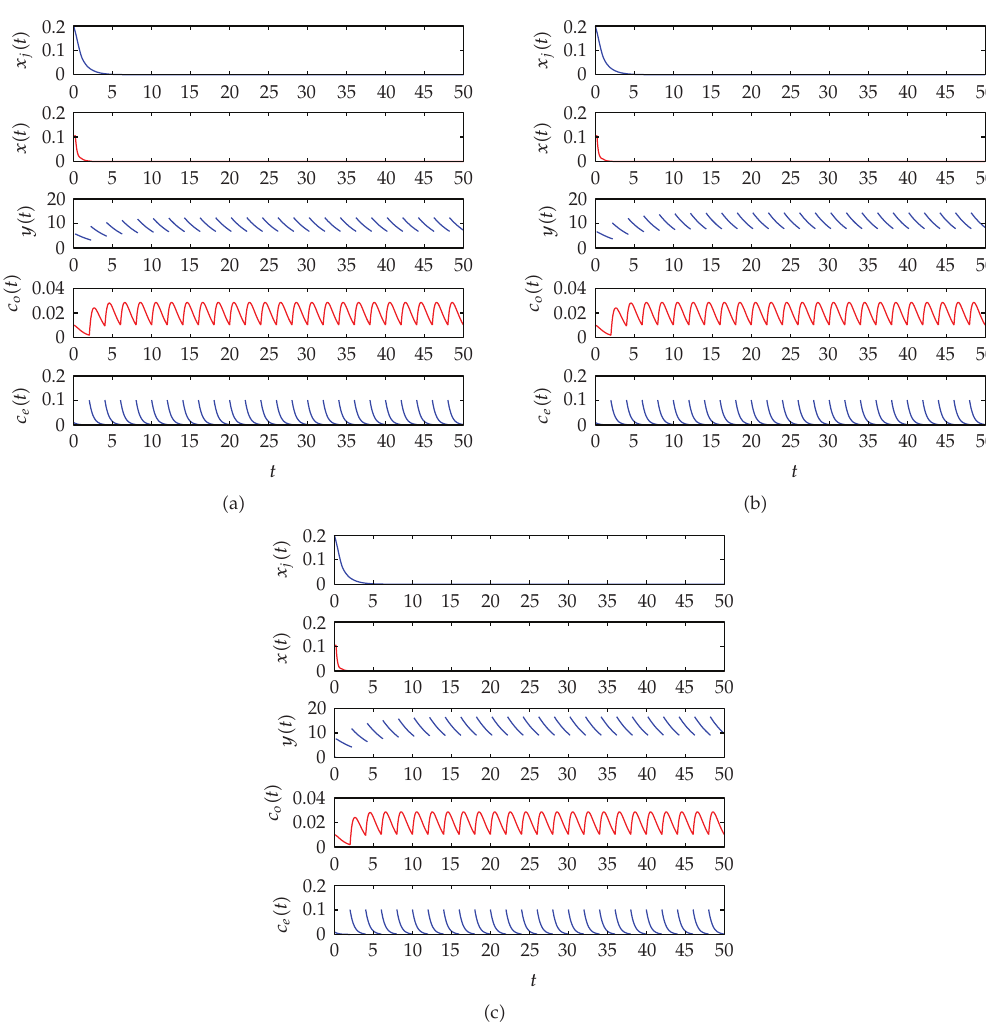
(cid:8) 5 . 5247. (cid:6) a (cid:7) 1